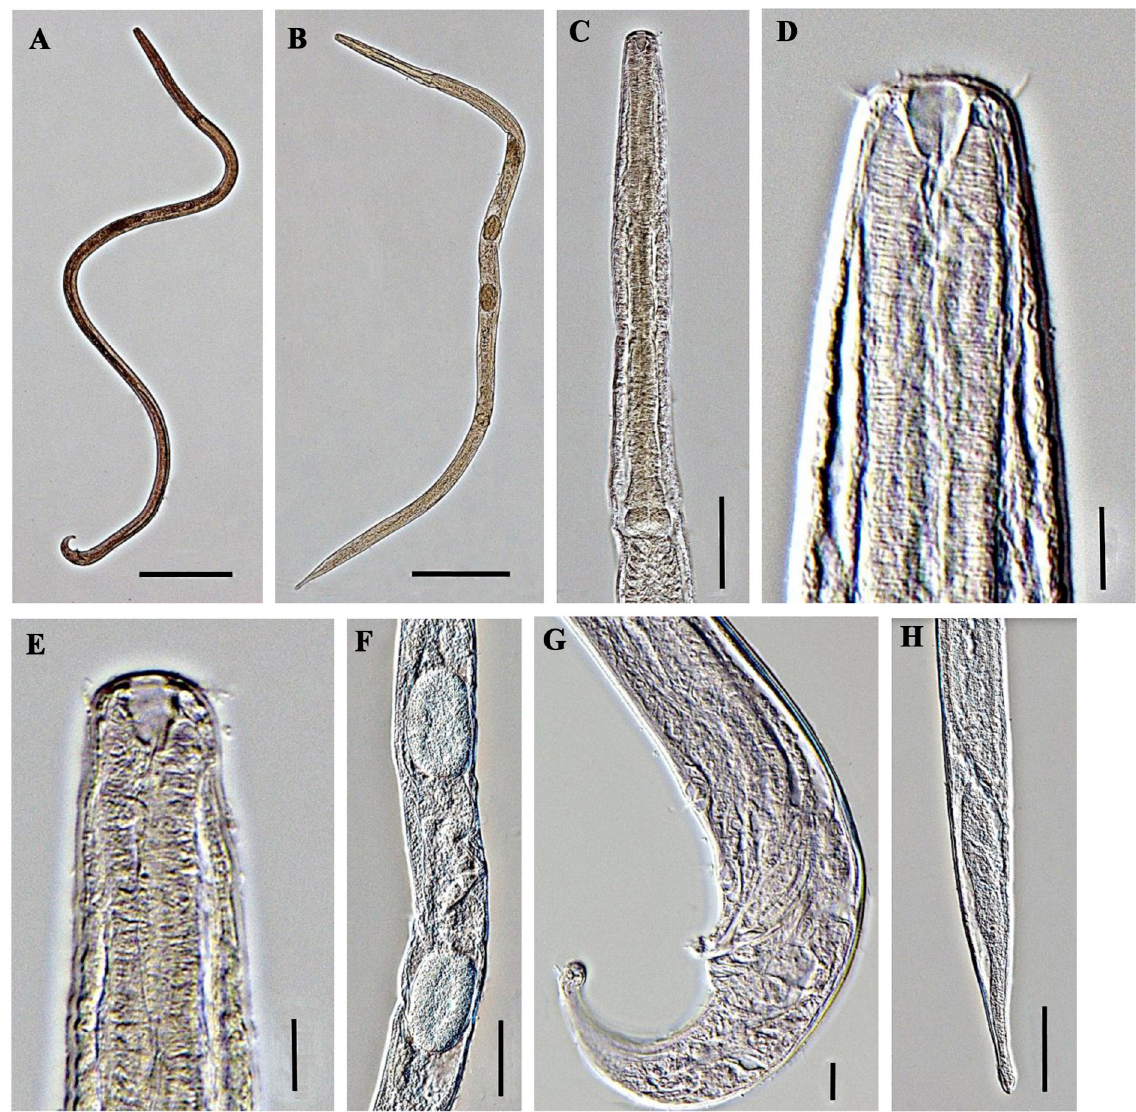
Fig. 4. Tobrilus juliae sp. nov., light micrographs. A . Entire male. B . Entire female. C . Male pharyngeal region. D . Female anterior end. E . Male anterior end. F . Female vulva region. G . Male posterior body end. H . Female posterior body end. Scale bars: A–B = 250 µm; C, F, H = 50 µm; D–E, G = 10